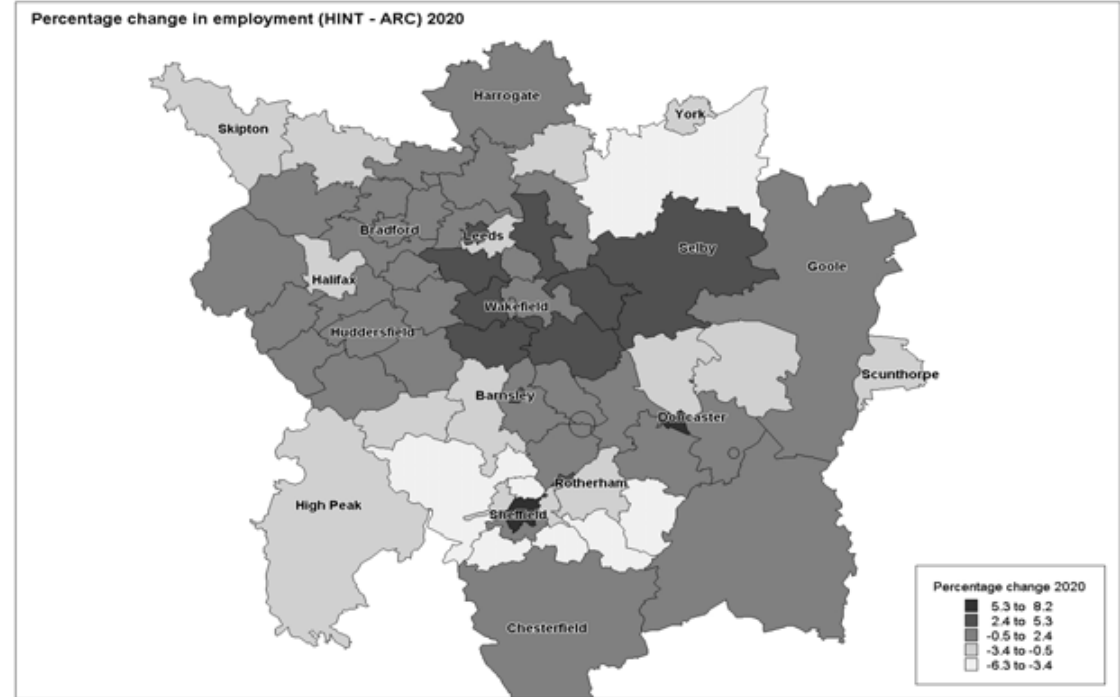
Figure 5. HINT package: impact on employment,